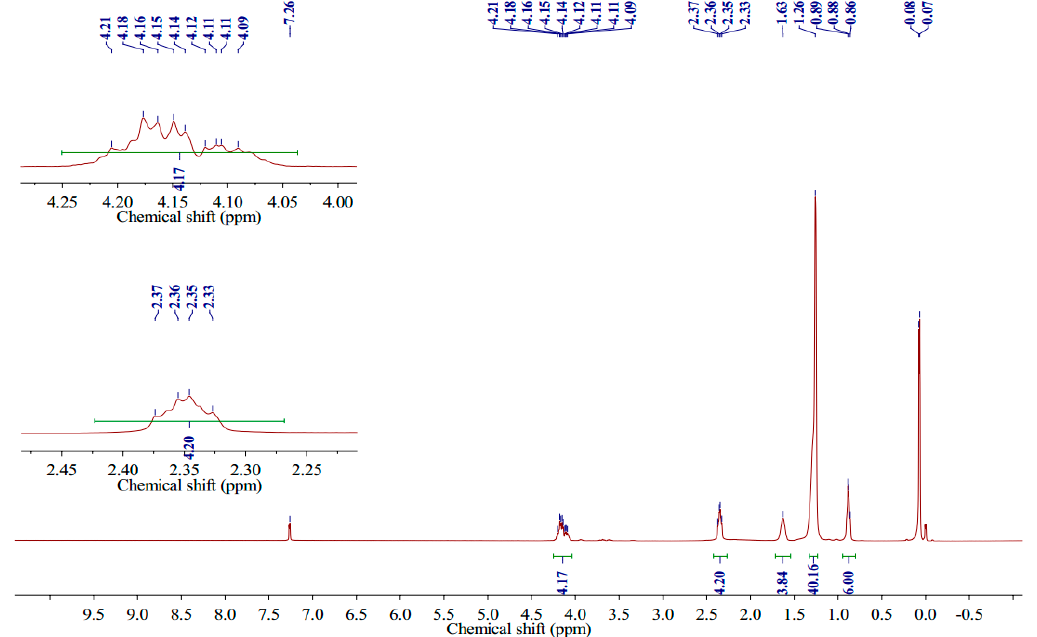
Figure 3. 1 H NMR spectra of synthesized 1,3-LP recorded in CDCl 3 with Me 4 Si as an internal standard.